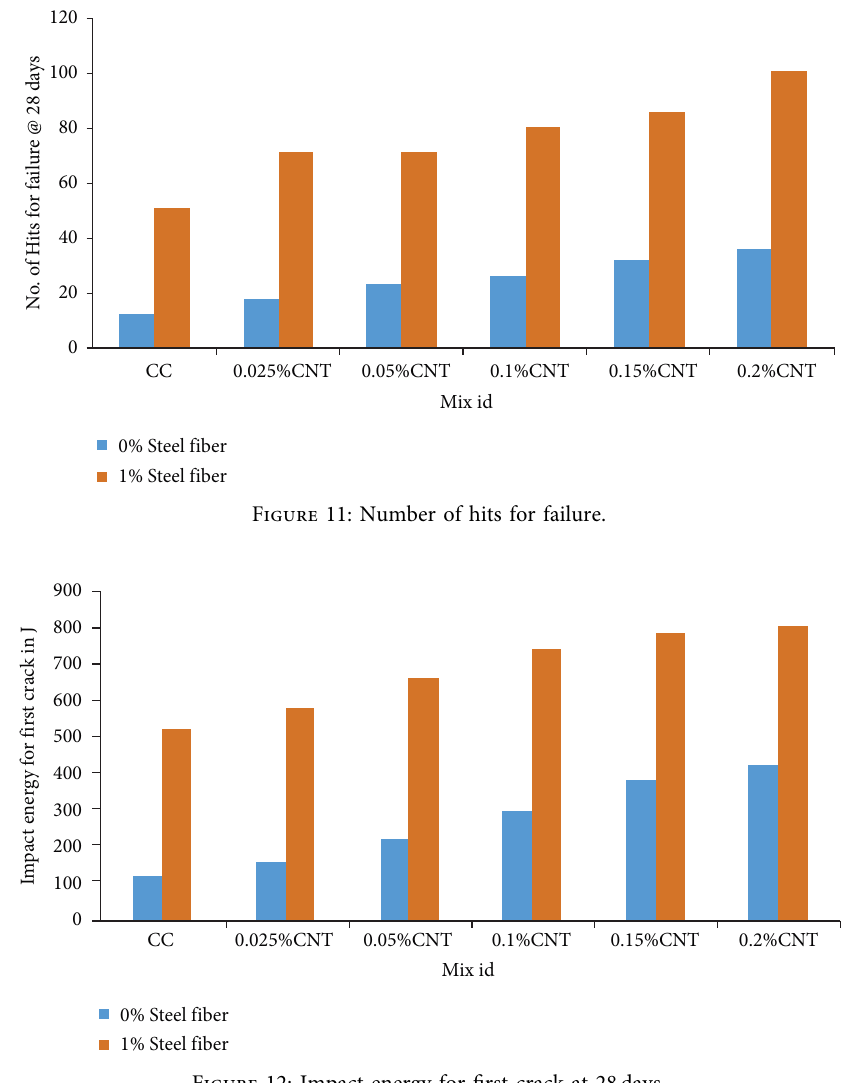
Figure 12: Impact energy for frst crack at